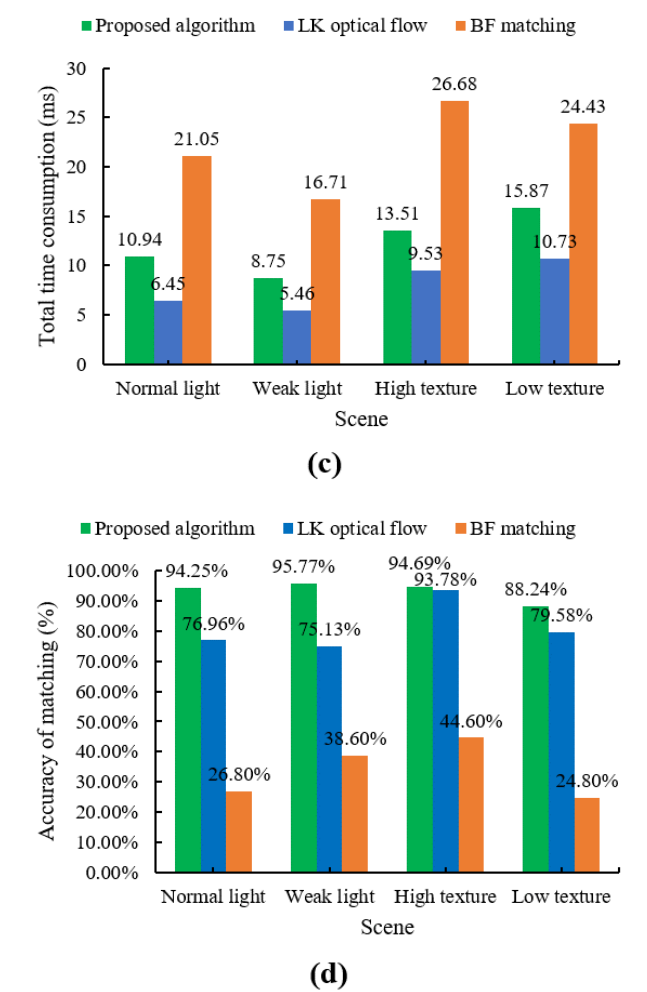
Figure 16. Statistical results of matching under three algorithms: ( a ) matching number; ( b ) time consumption of matching; ( c ) total time consumption; ( d ) accuracy of matching.